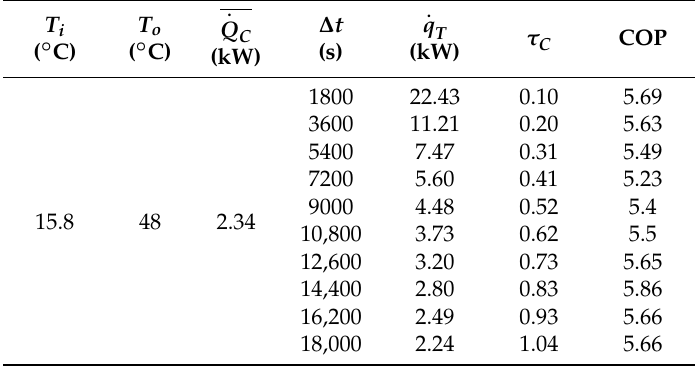
Table 3. Computation of the mean thermal